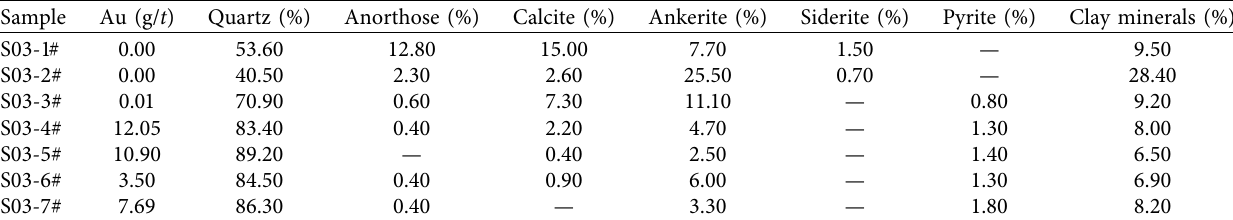
Table 3: X-ray diffraction analysis of all rock minerals.